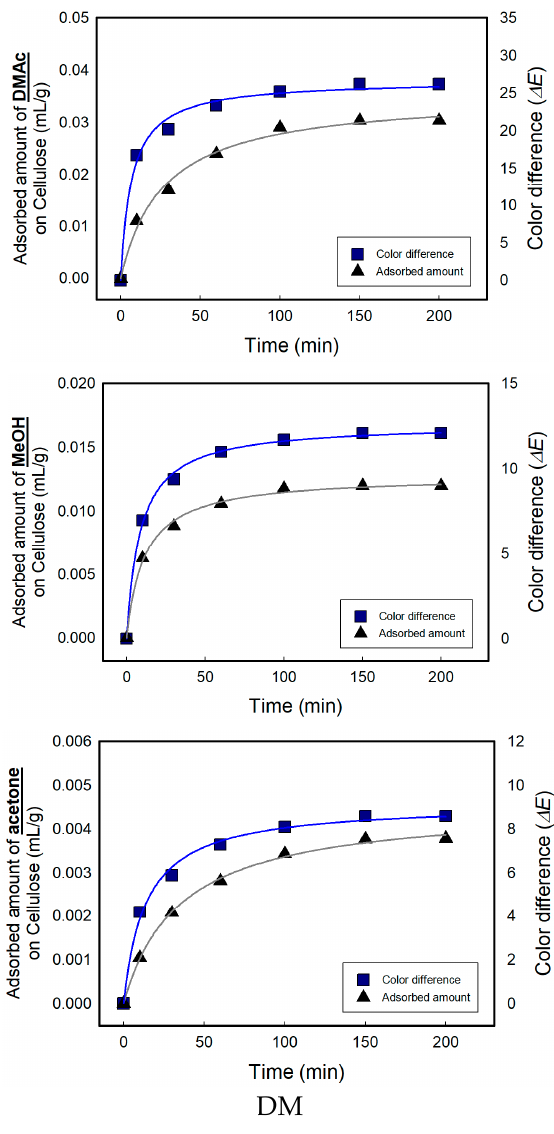
Figure 11. Relationship between the rate of adsorption of solvents on fabrics and color change.